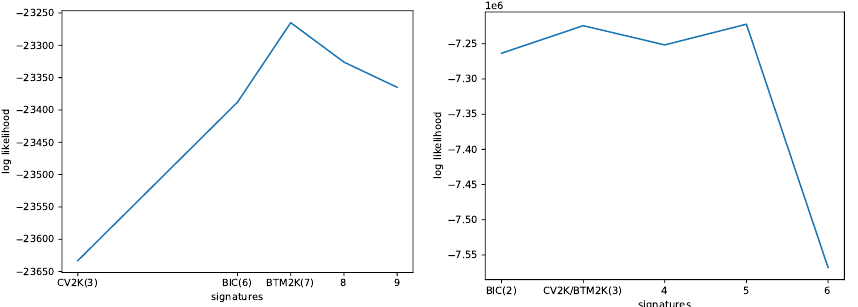
Figure 7. Log-likelihood of Mix on unseen data as a function of the number of signatures. Left : Mix was trained on MSK-IMPACT data and tested on the down-sampled WGS/WXS data. Right : Mix was trained on down-sampled WGS/WXS data and tested on the original